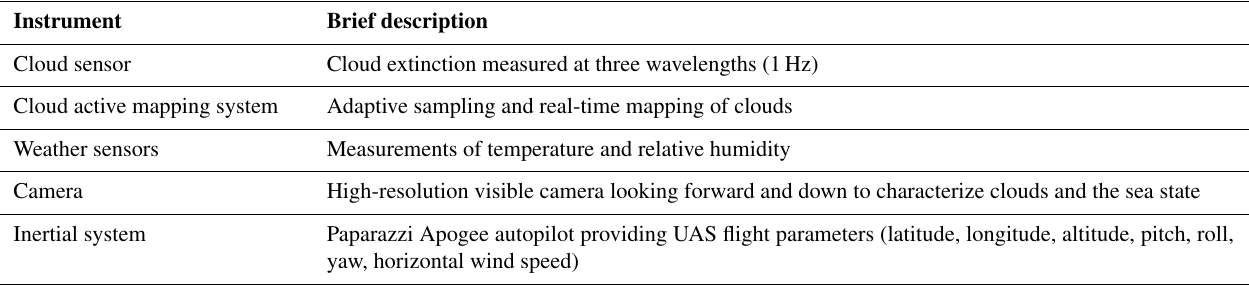
Table B15. Skywalker.